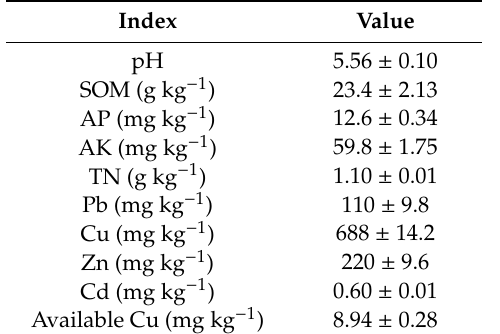
Table 1. Selected chemical properties of the soil sample used in the